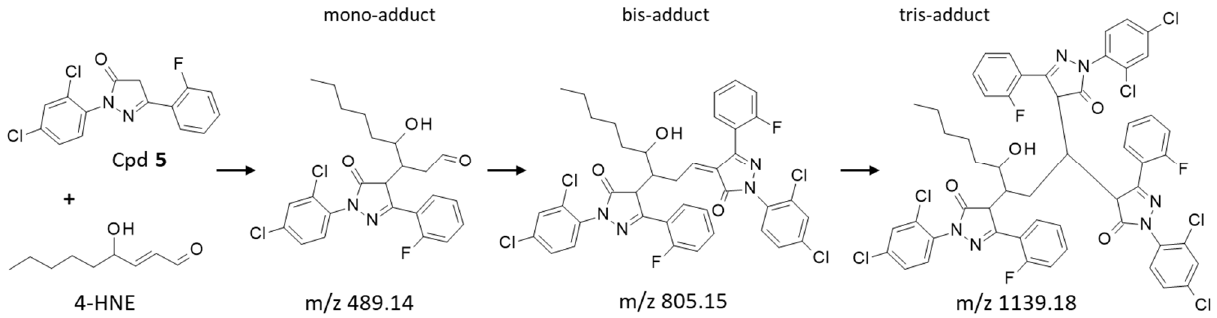
Figure 9. The reaction of compound 5 with 4-HNE generates three major covalent adducts: the mono-, bis- and tris-adducts, identified by their corresponding mass in the HRMS analyses. For the sake of convenience, the 3 adducts are represented in a linear form but they do not form necessarily in a sequential manner.